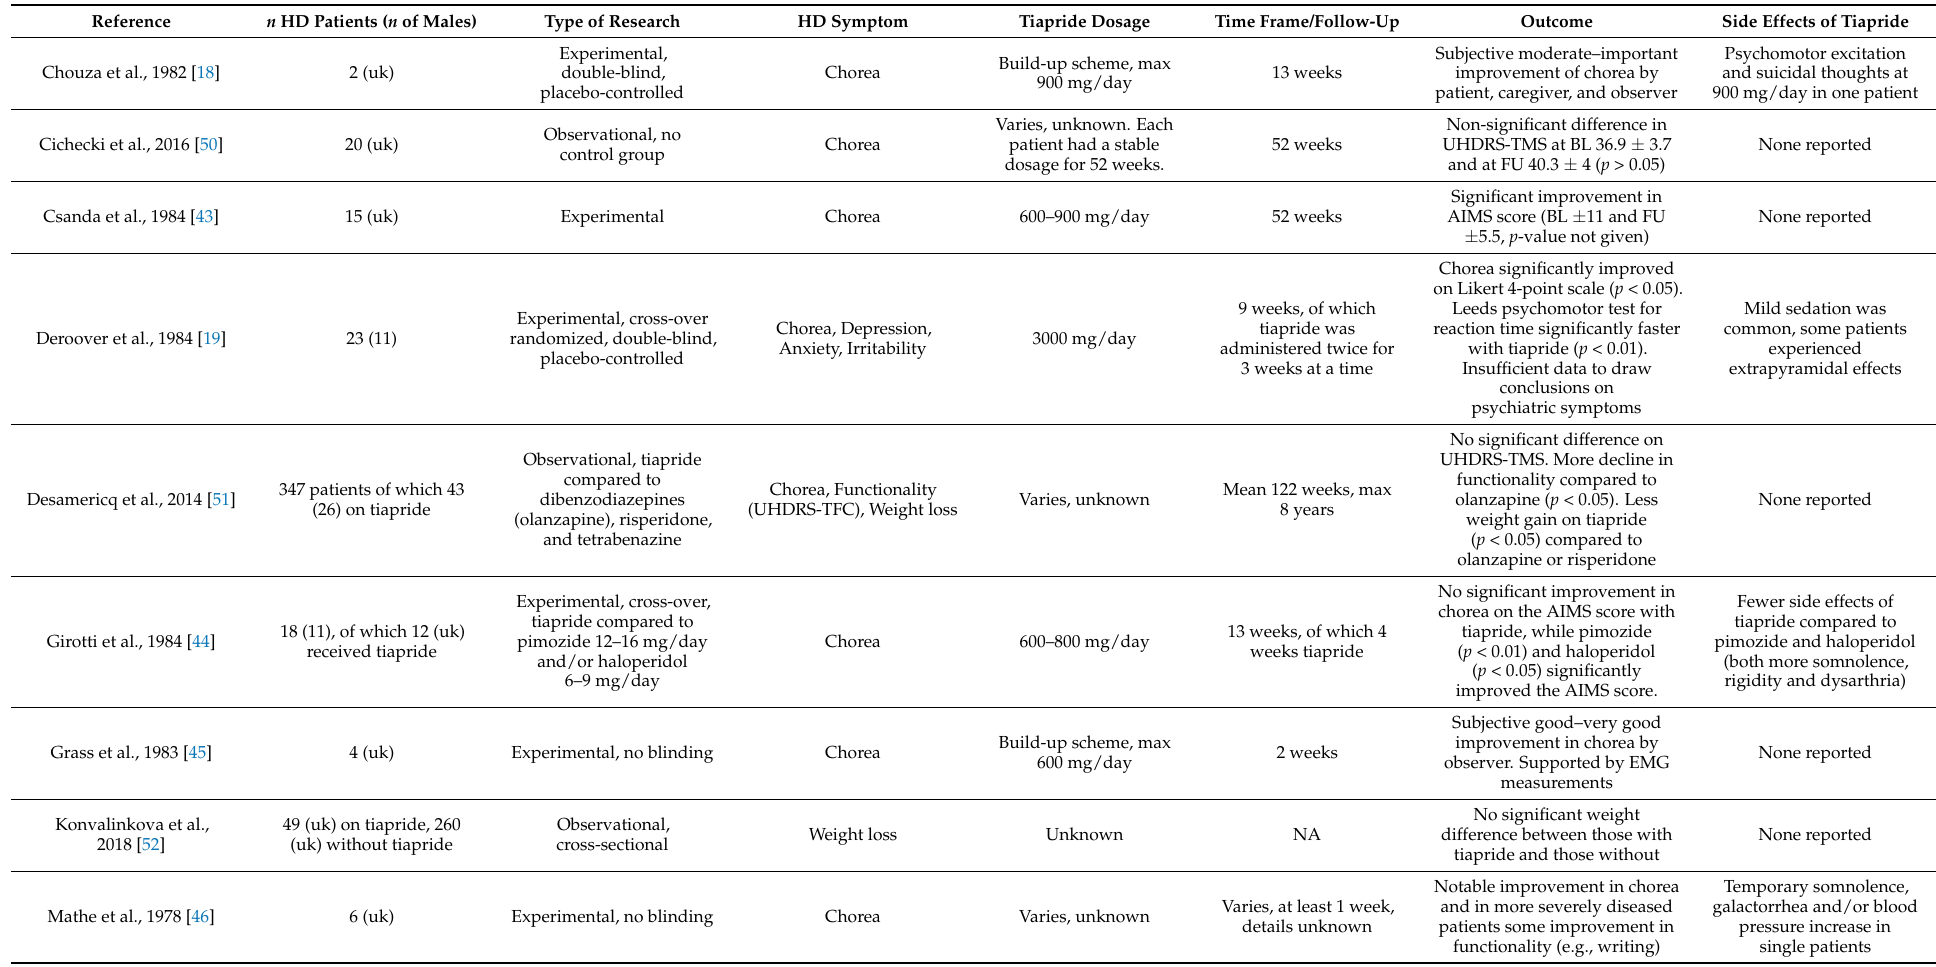
Table 1. Studies on tiapride in Huntington’s